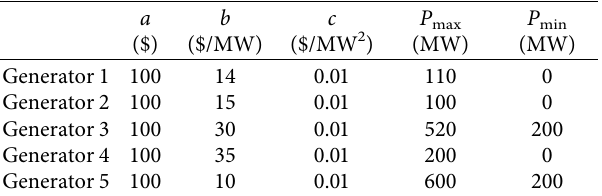
Table 1: Parameters of the